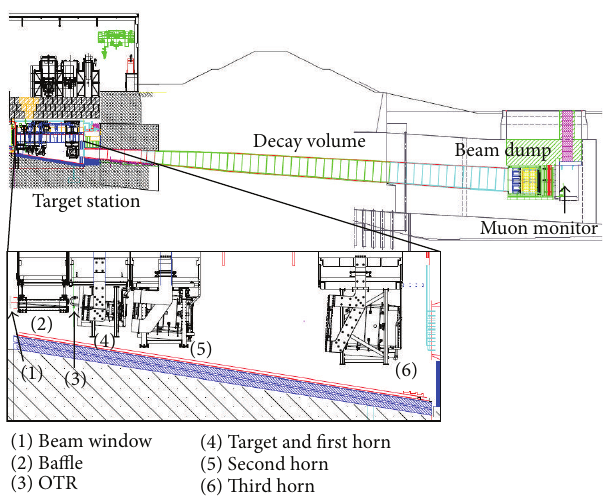
Figure 7: Schematic of T2K secondary beam line.